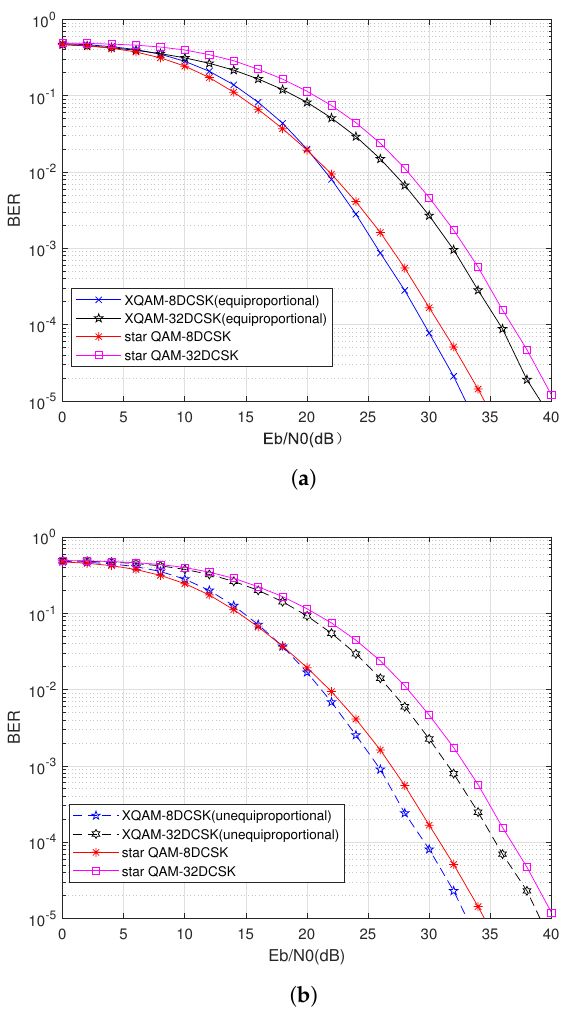
Figure 4. BER performance comparisons of between the XQAM- M DCSK and star QAM- M DCSK systems with ( a ) quiproportional path gains and ( b ) unquiproportional path